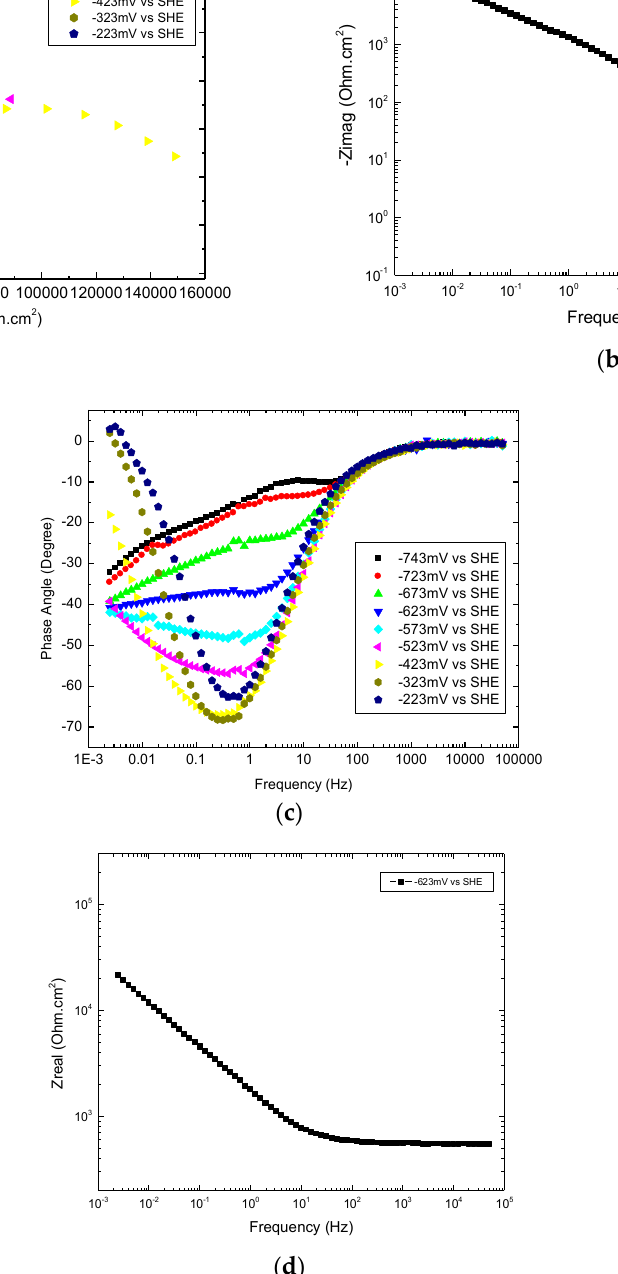
Figure A3. ( a ) Nyquist plot of Zn tests as a function of DC potential. Insert presents high-frequency portions of the Nyquist plots. ( b ) Plot of log im. Vs. log freq. of Zn test at − 623 mV. ( c ) Phase angle as a function of frequency and potential of Zn test. ( d ) Log re. vs. log freq. of Zn test at − 623